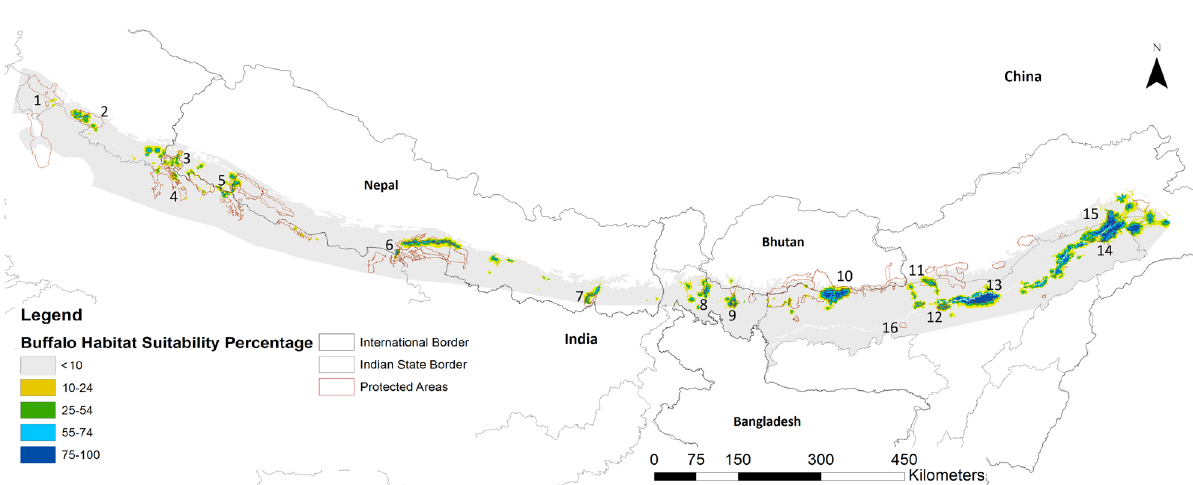
Figure 4. Distribution probability of wild swamp buffalo across the Terai-Brahmaputra floodplain, where 1-Jhilmil Jheel, 2-Corbett NP, 3- Shukalaphanta NP, 4- Kishanpur WLS, 5-Keterniyaghat WLS, 6- Chitwan NP-Valmik TR-Parsa WLS Complex, 7-Koshi Tappu RAMSAR Site, 8- Gorumara WLS, 9- Jaldapara WLS, 10- Manas-Royal NP-Manas NP Complex, 11-Sonai Rupai WLS, 12- Laokhowa-Burachapori WLS, 13- Kaziranga NP, 14-Dibru Saikhowa WLS, 15- D’Ering Memorial WLS, 16- Pobitora WLS Created in ESRI ArcMap 10.5.1 (https ://suppo rt.esri.com/en/Produ cts/Deskt op/arcgi s-deskt op/arcma p/10-5-1#downl